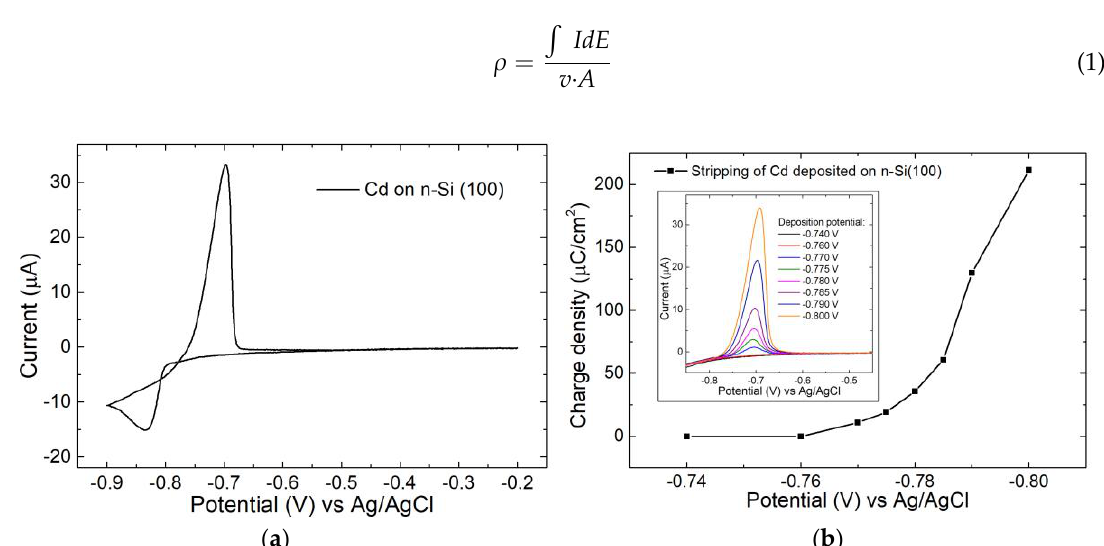
Figure 1. ( a ) Cyclic voltammetry (CV) of Cd 2 + solution on n-Si in sulfuric acid between − 0.2 V to − 0.9 V, scan rate 10 mV / s; ( b ) charge density of Cd deposited varying the deposition potential, calculated from the stripping voltammetry (inset) performed between − 0.85 V and − 0.4 V, scan rate 10 mV / s. The electrodeposition of Cd (sample A) was performed with a charge-controlled deposition: −0.8